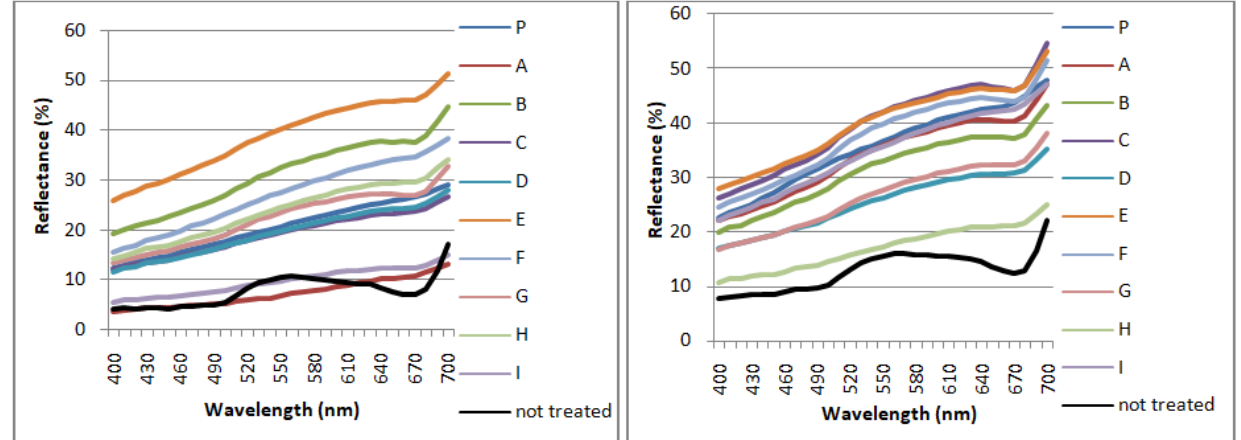
Figure 5. Full spectrum color measurement of treated zones in Area 1 ( left ) and Area 2 ( right ). P = Preventol ® RI50, A = Eucalyptus, B = Basil, C = Essenzio, D = Cloves, E = YOCOCOIL, F = Biotersus, G = Thyme, H = Pine tree, I = Tea tree and black = untreated zone. Standard deviation is about 0.75 < SD > 2.90.